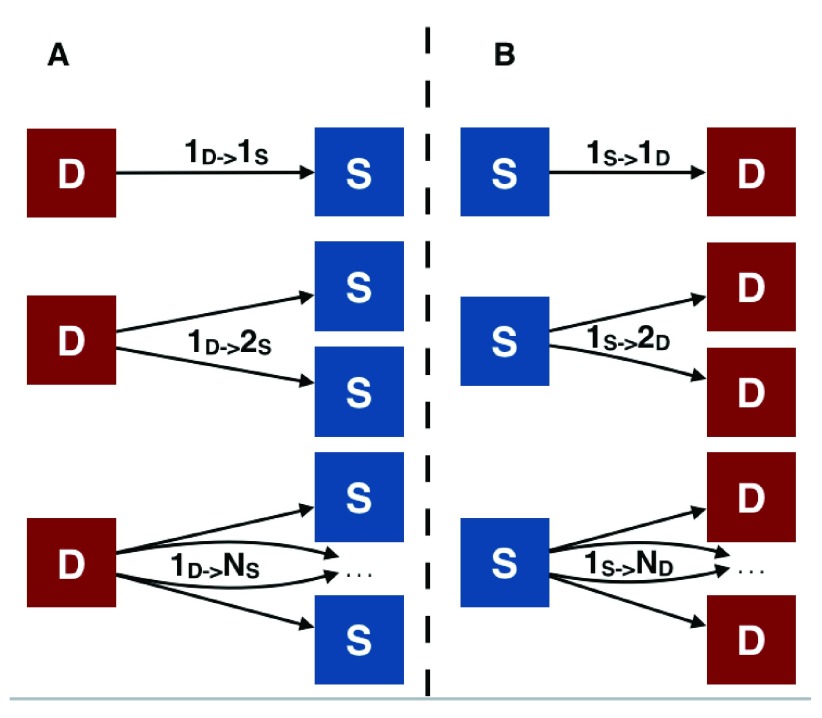
Summary of possible mismatches between DAB and SB clusters.Mismatches of SB and DAB derived clusters (marked by
S and
D respectively) can occur in two directions. Panel
A: possible cases of mismatch when counting the number of SB clusters the sequences in a DAB cluster are assigned to. 1
d → 1
s denotes that all sequences from the D cluster are assigned to the same S cluster. 1
d →
Ns denotes that sequences in a single D cluster are assigned to
N distinct S clusters with
N ≥ 1. Similarly, (panel
B) 1
s →
Nd denotes that sequences in a single S cluster are assigned to
N distinct D clusters with
N ≥ 1.